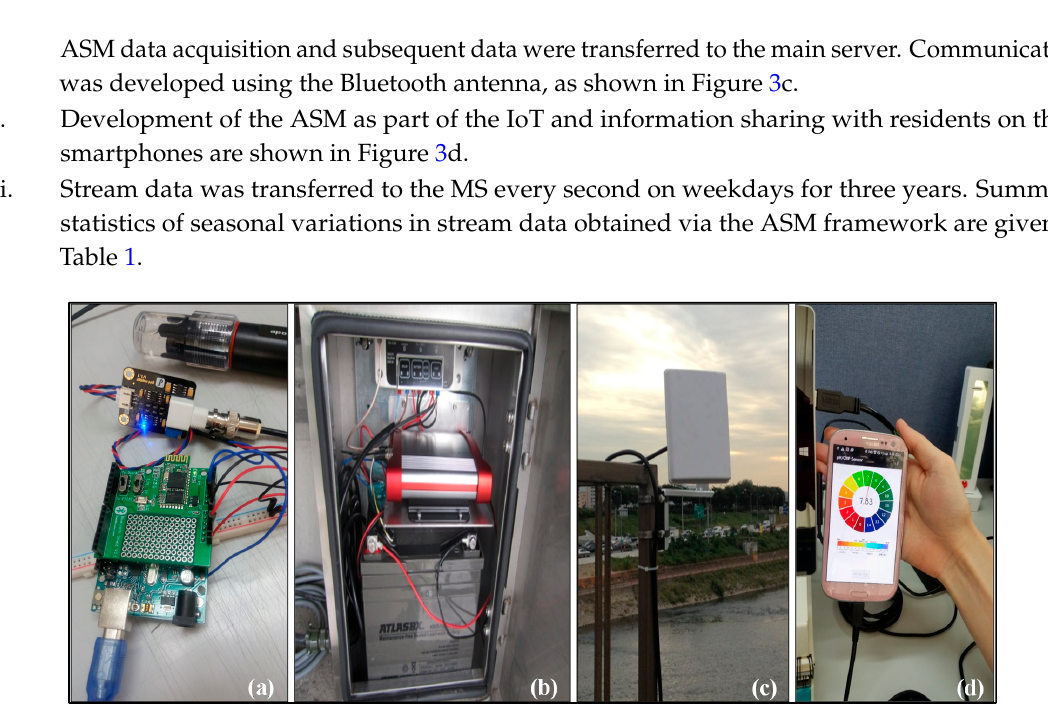
Seasonal Parameter